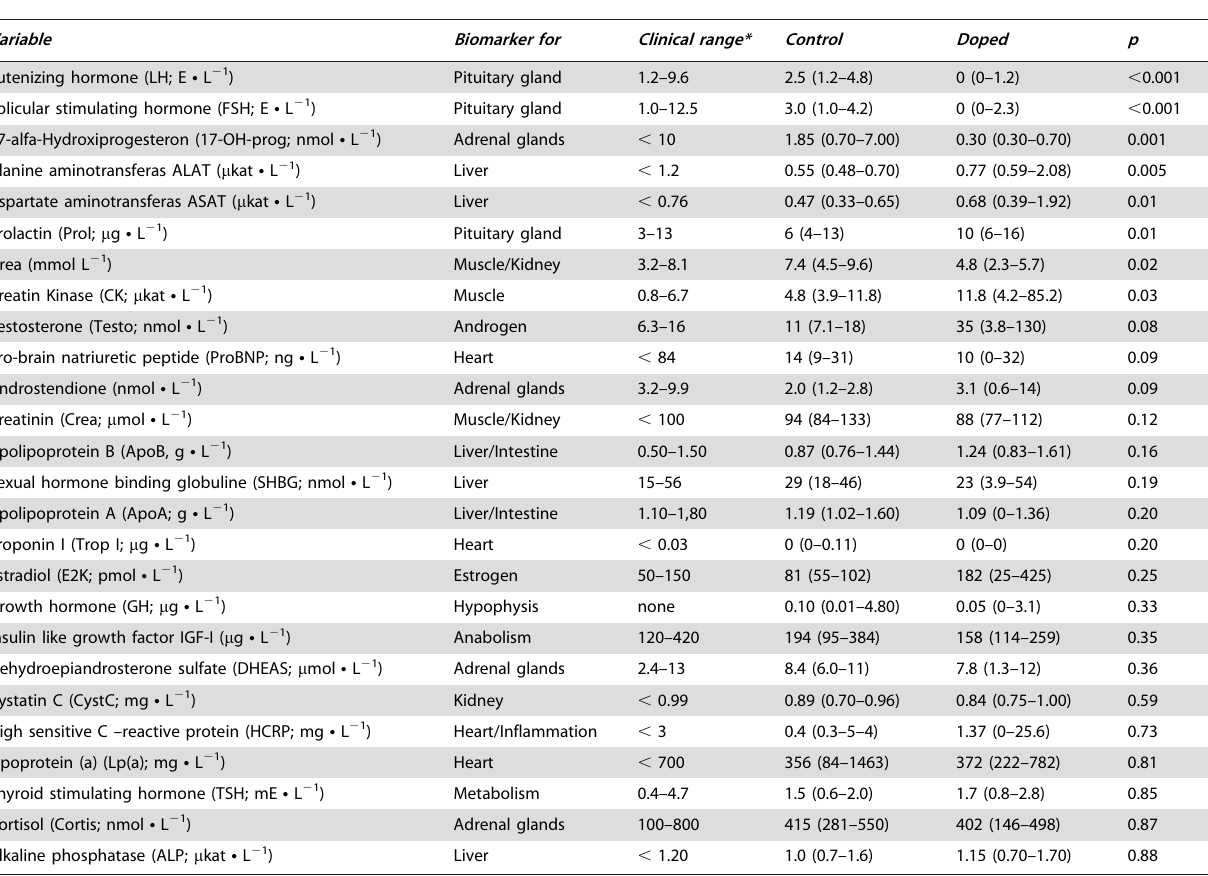
Table 3. Blood hormone levels [median